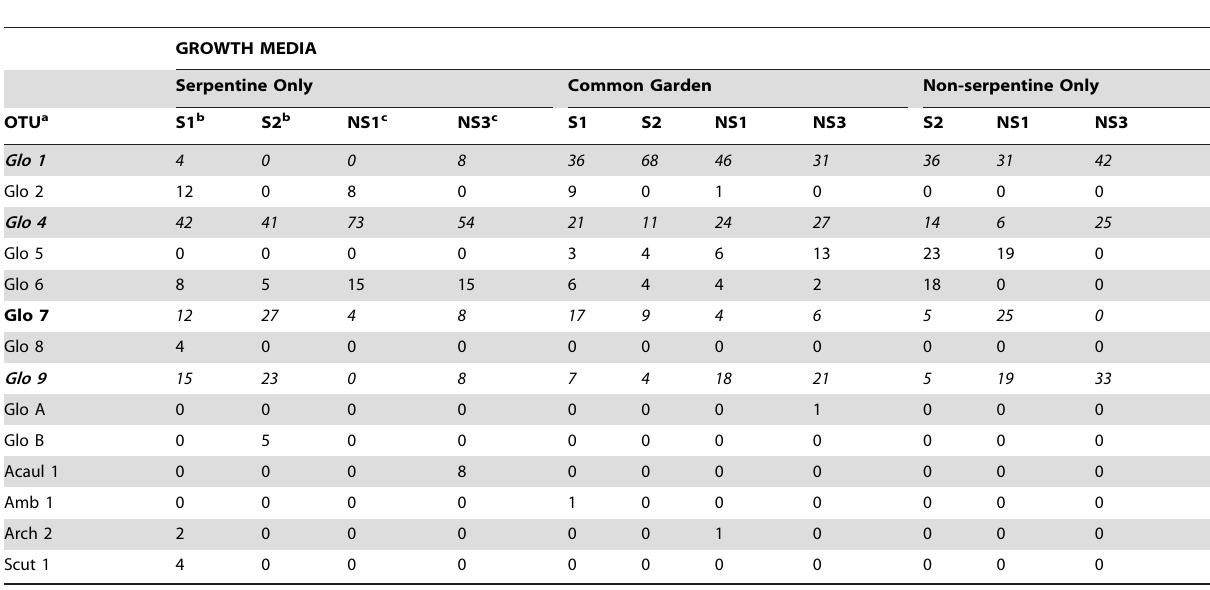
Table 2. Relative abundance matrix of AM fungal taxa associated with serpentine and non-serpentine ecotypes of Collinsia sparsiflora growing in a common garden of serpentine and non-serpentine AM